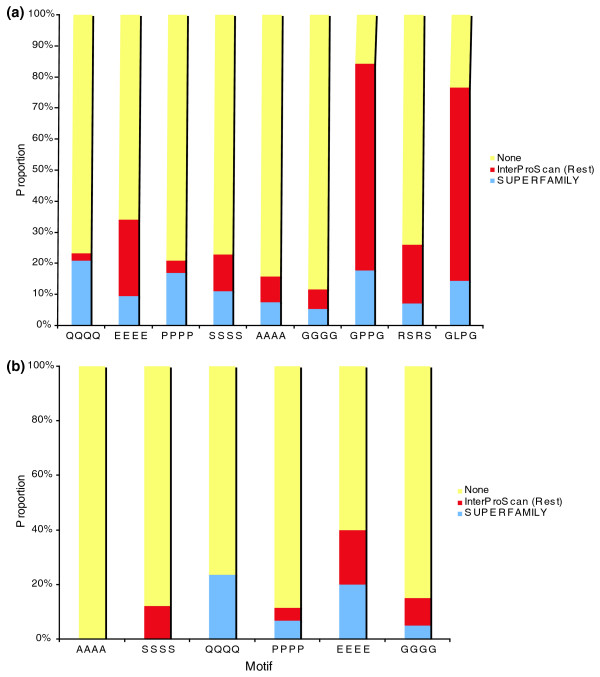
Proportions of AARs found within identifiable protein domains. (a) Tandem repeats; (b) C4 repeats. Repeats found within SUPERFAMILY domains are indicated by black bars. Additional repeats found within InterProScan domains are shown in grey and those outside domains by white bars. AARs are ordered by frequency.